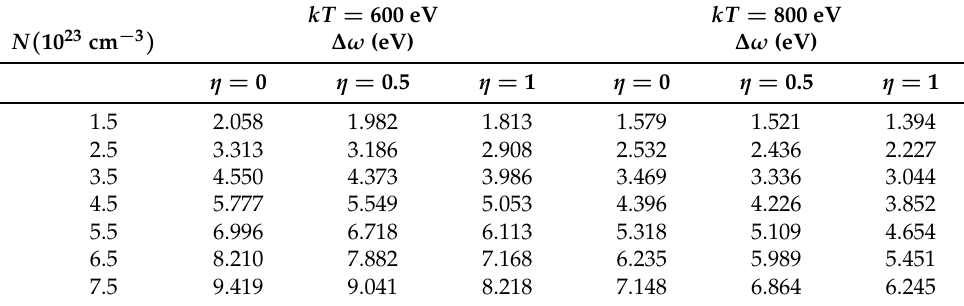
Table 2. The redshifts ∆ ω ( eV ) of the β emission line for the He-like Cl ion derived from the fit coefficients listed in Table 1 at 600 eV and 800 eV as functions of the plasma density N in ( 10 23 cm − 3 ) with the size parameters η = 0,0.5, and